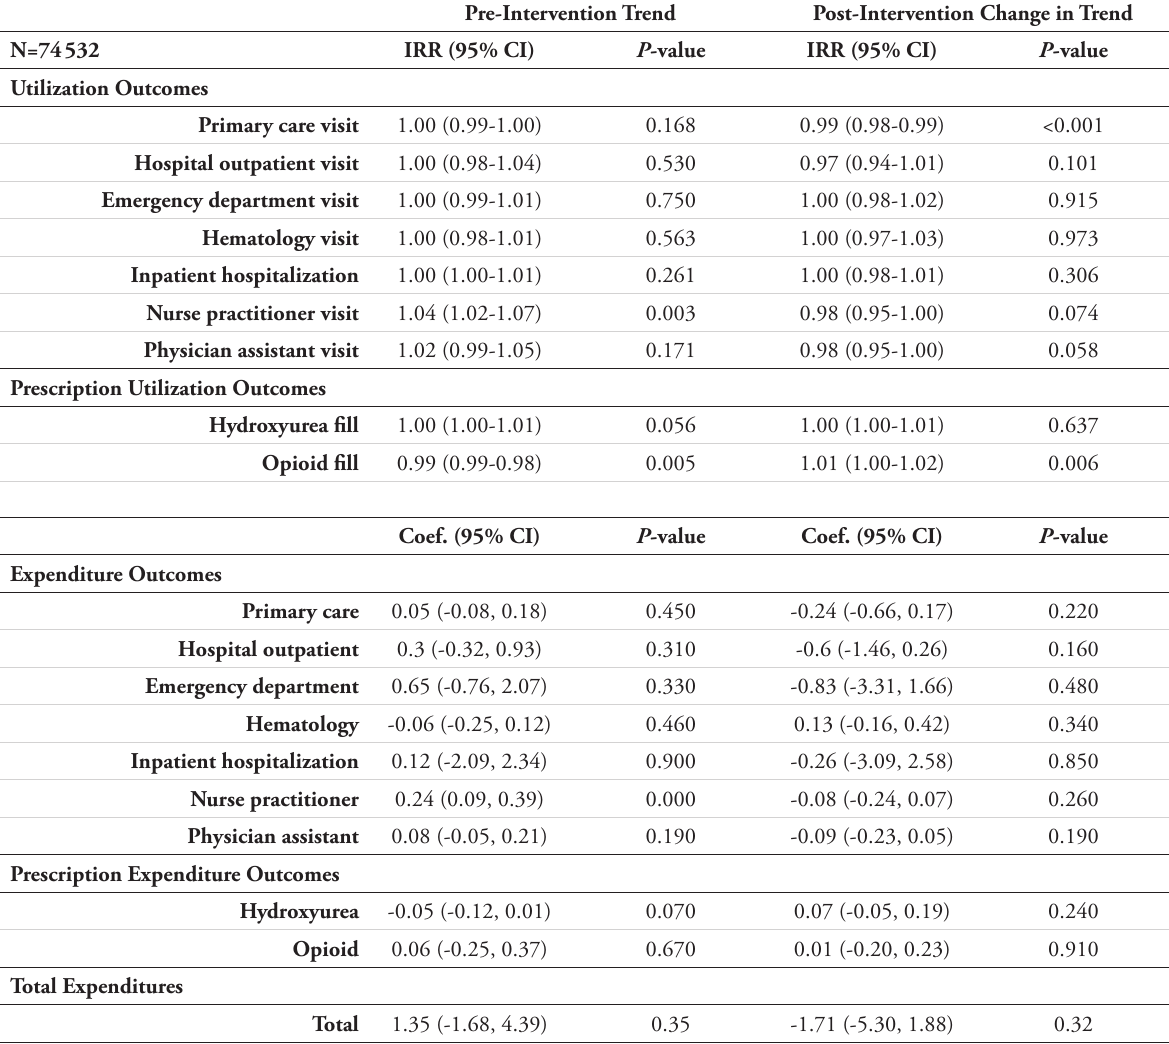
Table 3. Interrupted Time Series Regression Results for Primary Outcomes of Interest Pre-Intervention